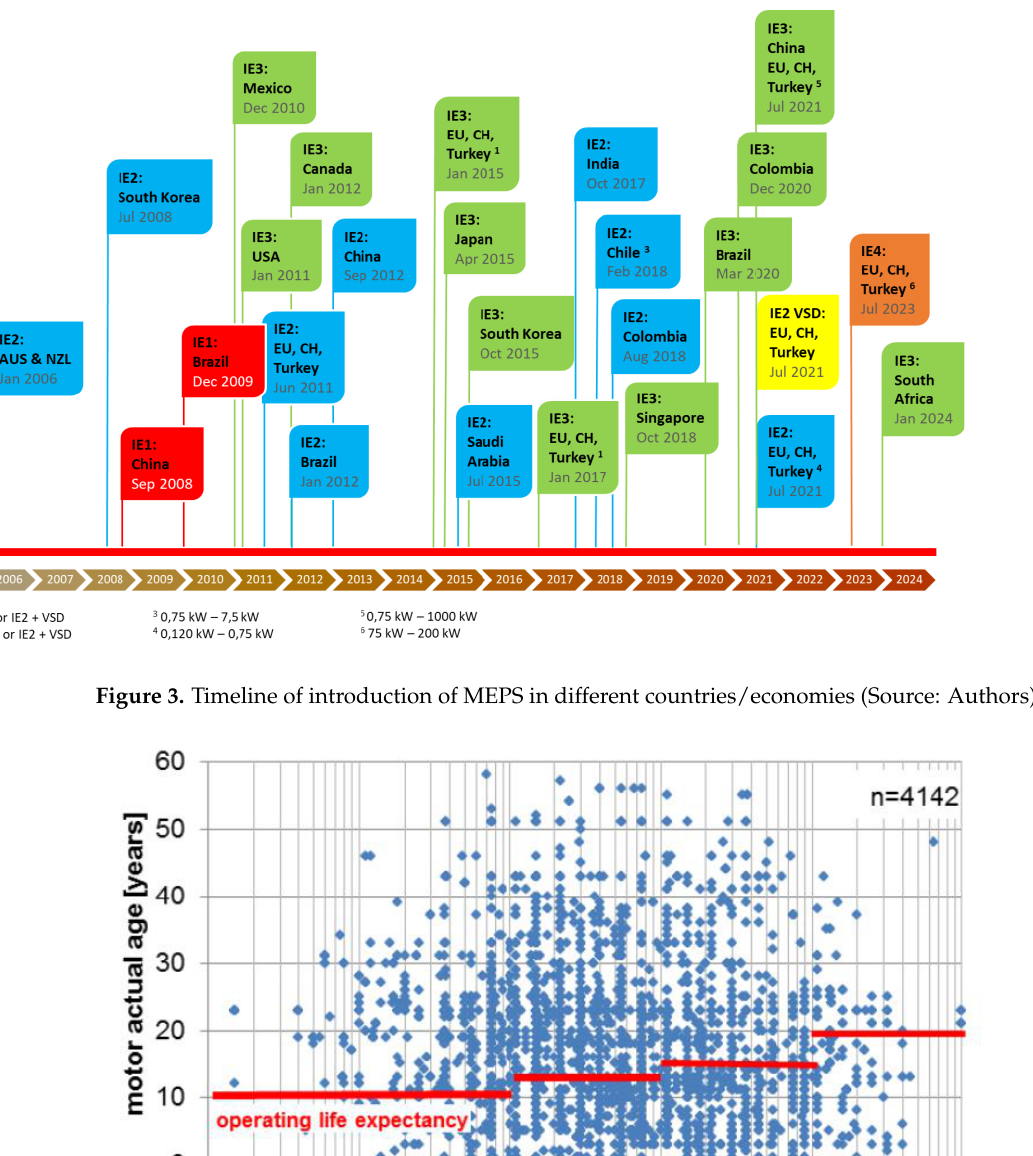
Figure 3. Timeline of introduction of MEPS in different countries/economies (Source: Authors).